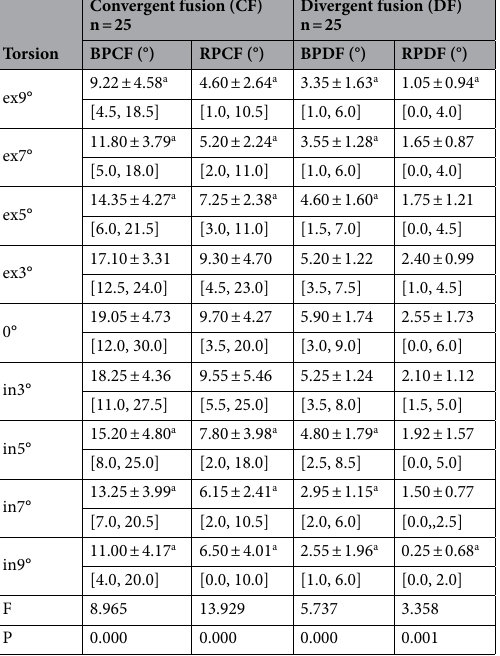
Table 2. BPCF, RPCF, BPDF and RPDF of m-F at different rotations. ex, extorsion; in, intorsion. a P < 0.05 comparison with the value in the baseline (0°) by Tukey multiple comparison tests.